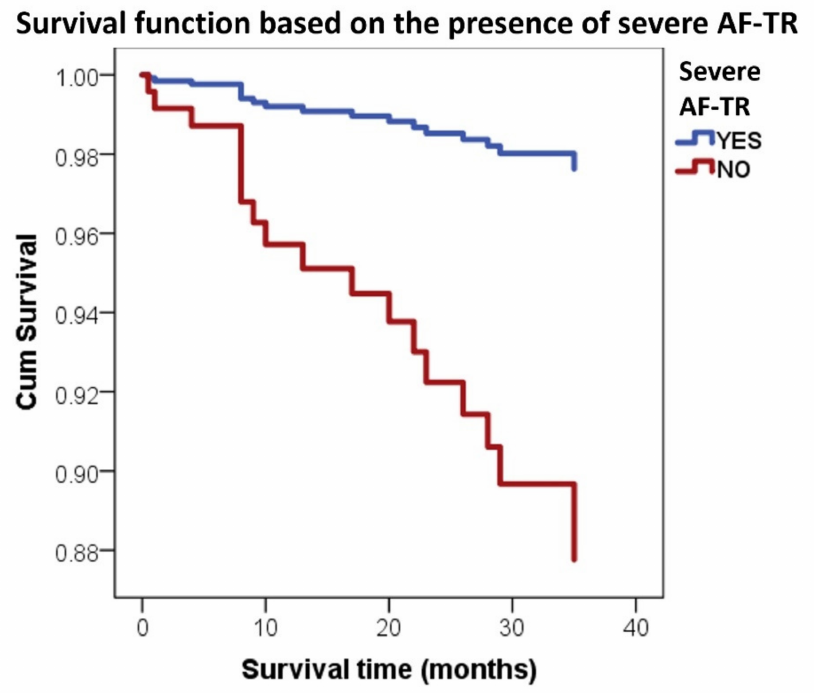
Figure 2. Survival analysis of patients with and without severe